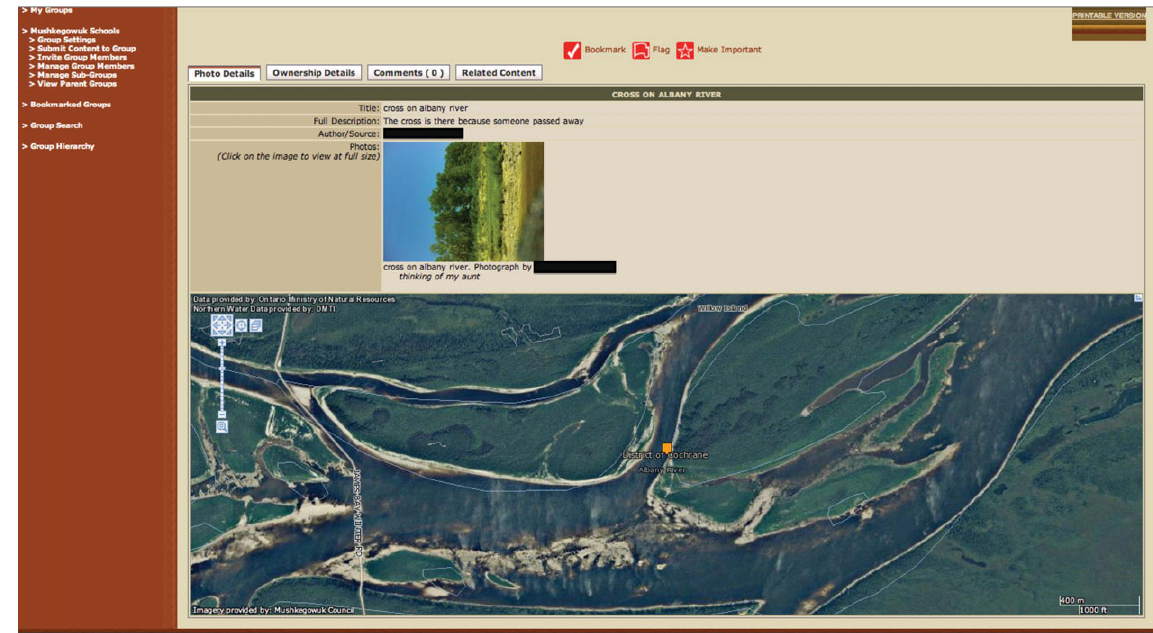
Finding a spot to go fishing or something. (Participant #3) Look for whitefish. (Participant #1) The youth were able to see the tool’s potential in connect- ing them to the land and associated traditional activities.